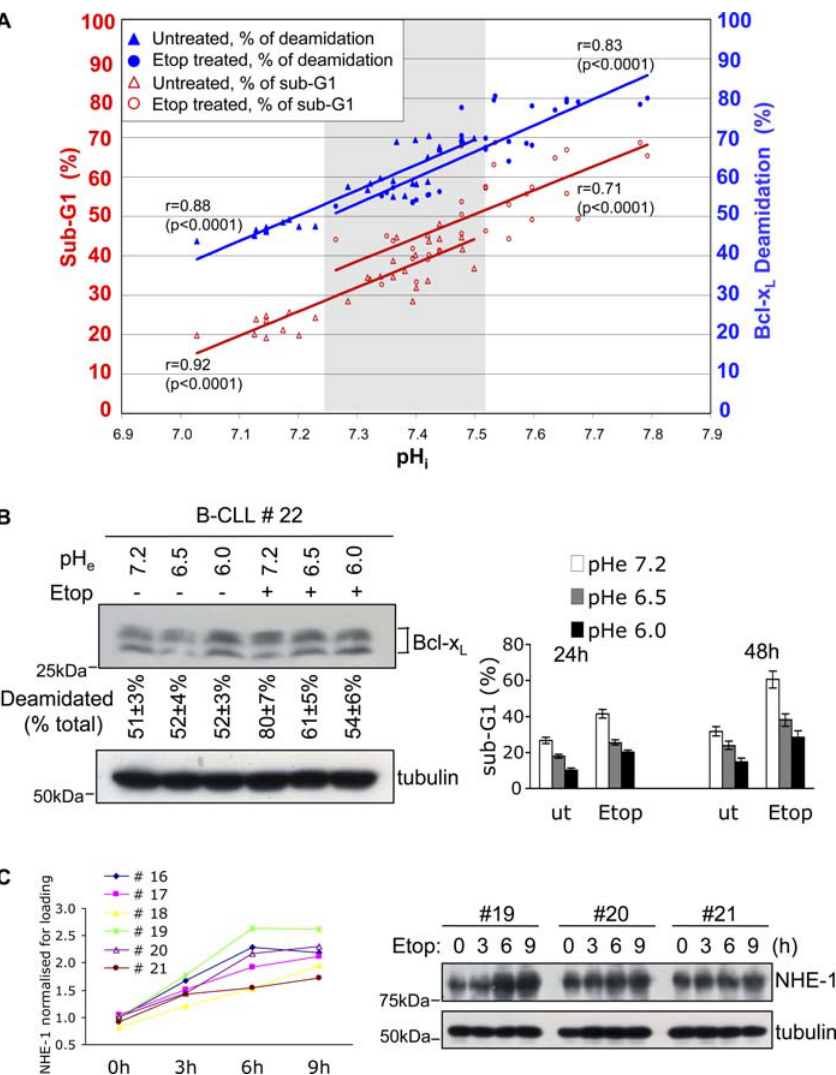
Figure 6. DNA Damage Induces NHE-1 Expression, and Enforced Alkalinisation Promotes Apoptosis of Human B-CLL cells (A) Enforced alkalinisation of cancer cells from patients ( n ¼ 10) with B-CLL causes Bcl-x L deamidation and associated cell death. Treatment with etoposide (Etop) in vitro further amplifies cell death. Patients’ cells (PBMC, in the range 85%–95% CD19 þ B220 þ ) were incubated at pH e values of 7.2, 8.0, or 8.5, and the pH i values were monitored by SNARF-1 staining using flow cytometry. Apoptosis was evaluated by measurement of sub-G1 peaks using flow cytometry. The data shows pooled results from ten patients via 30 values per treatment condition: due to identical values, some symbols overlap. The correlation coefficients ( r ) of deamidation or sub-G1 versus pH i are shown for each treatment. The p value (significance) for each correlation is shown in parentheses. The correlation coefficients of sub-G1 versus deamidation are r ¼ 0.92 ( p , 0.0001) for untreated cells and r ¼ 0.87 ( p , 0.0001) for etoposide treated cells. (B) Purified PBMC from B-CLL patients were cultured for 24 h in media at the pH shown, with/without etoposide for 48 h, and then analysed for Bcl-x L deamidation by immunoblotting (left panel). The upper and lower bands were quantified and the upper deamidated Bcl-x L band was expressed as a percentage of total Bcl-x L . The percentages shown below each lane are means 6 SD ( n ¼ 4). The same cell aliquots cultured in RPMI/10% FCS for 24 h or 48 h were analysed for apoptosis by sub-G1 staining (right panel). (C) Assessment of NHE-1 expression in B-CLL patients’ samples following exposure to etoposide for the times shown. Representative immunoblotting results are shown for three patients in the right panel and the values for six patients (normalized for tubulin loading) are graphed in the left